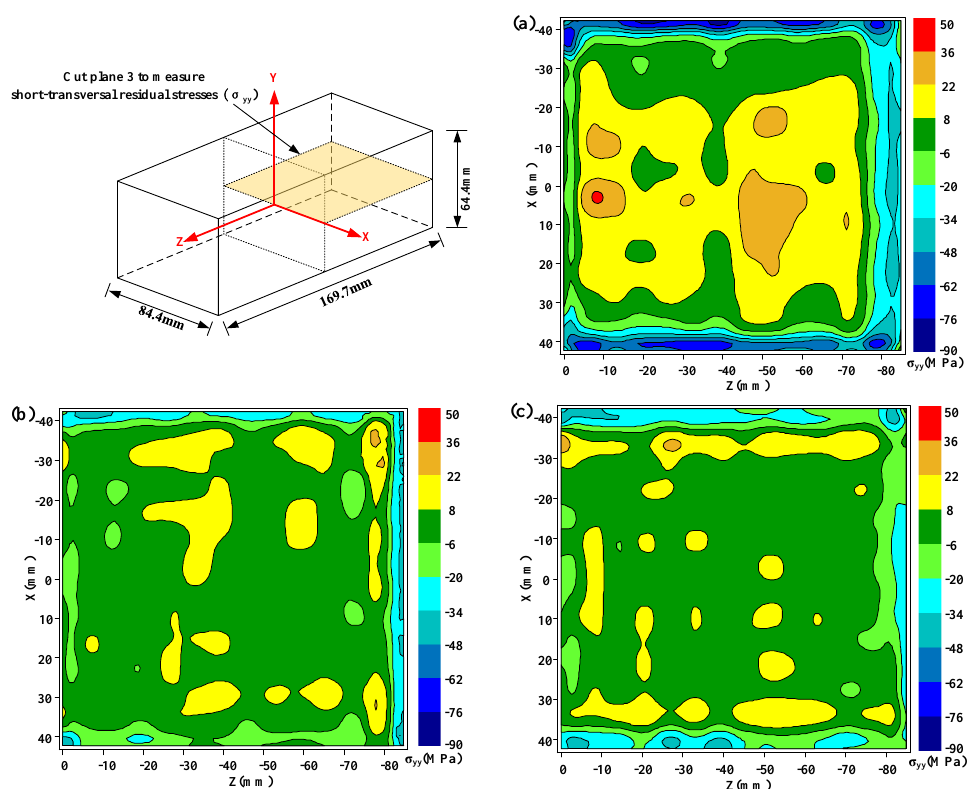
Figure 8. Long-transversal residual stresses ( σ xx ) on cut plane 2 in three different conditions: ( a ) as-quenched specimen; ( b ) heat-treated specimen; ( c ) cold-treated specimen. (The specific reconstruction process is omitted.)